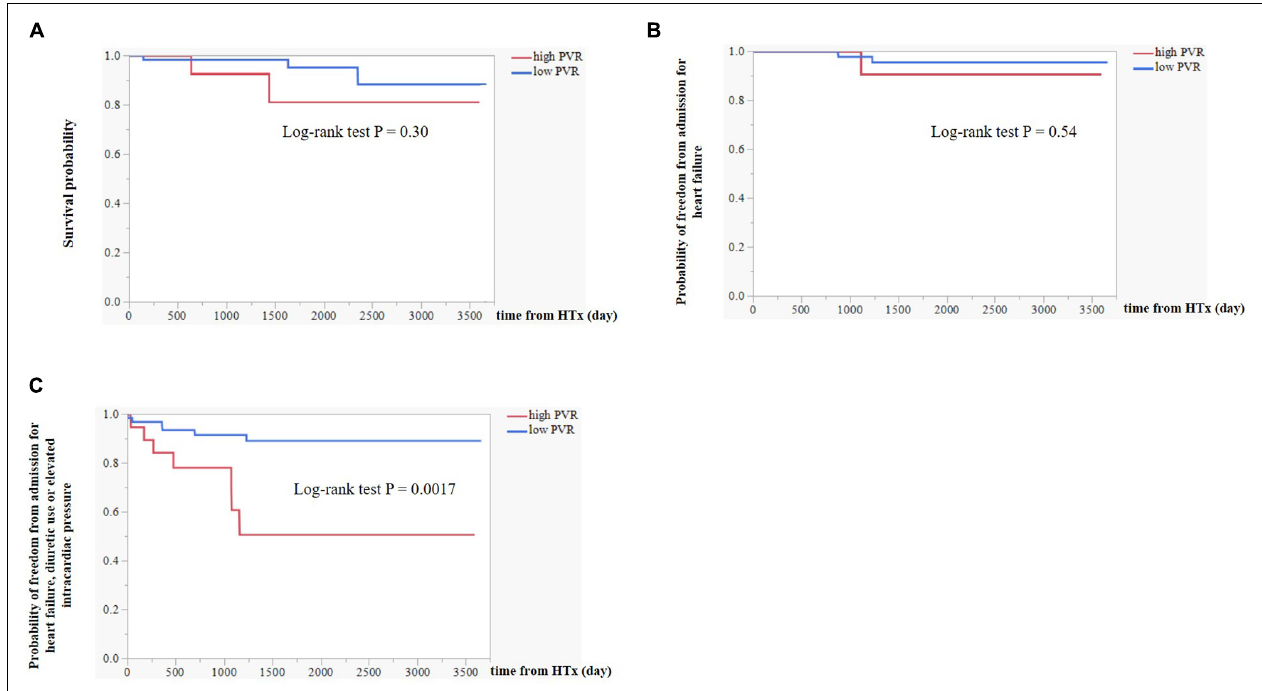
FIGURE 4 | (A) Kaplan–Meier survival curve analysis between high PVR group and low PVR group. (B) Differences in event-free survival curves of admission for heart failure between high PVR group and low PVR group. (C) Differences in event-free survival curves of the composite event including admission for heart failure,